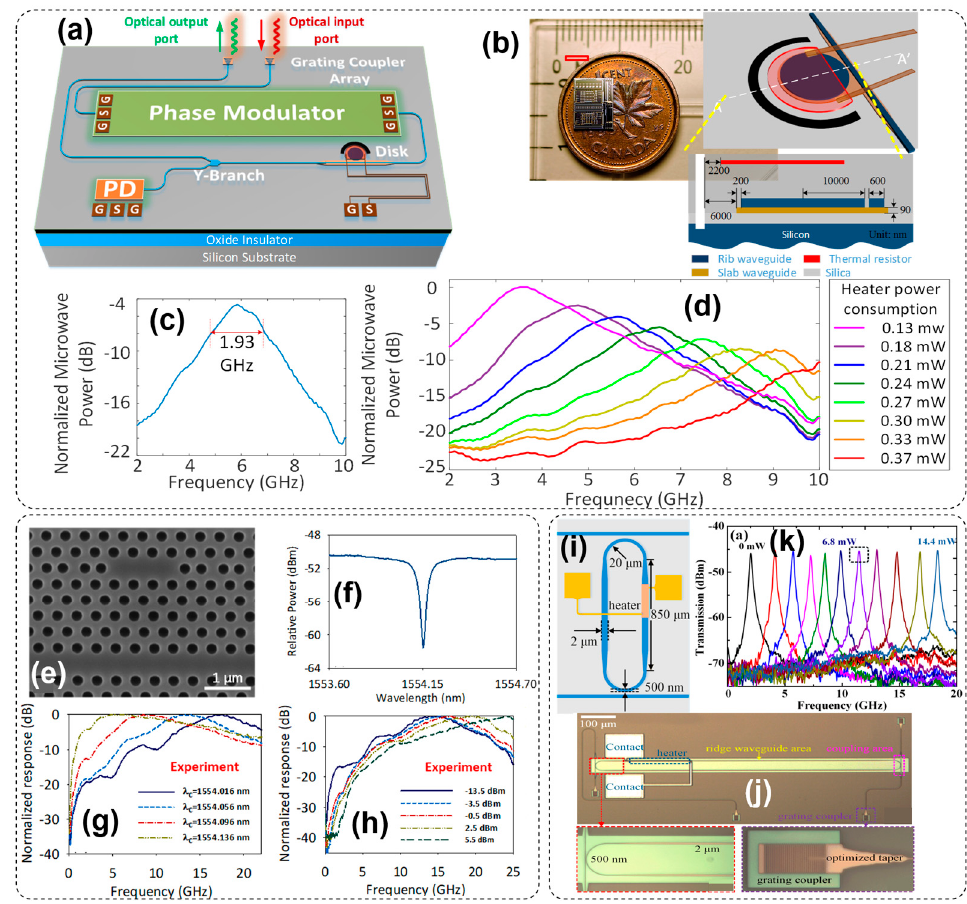
Figure 17. Implemented bandpass MPFs based on silicon micro-resonators. ( a – d ) On-chip integrated MPF based on microdisk resonator (MDR) reported in [61]: ( a ) perspective view of the proposed MPF, ( b ) image of the fabricated silicon photonic chip, schematic view of the thermally tunable MDR, cross-sectional view of the MDR, ( c ) experimental results of MPF and ( d ) measured frequency responses tuning from 3 to 10 GHz. Courtesy of and adapted from Jianping Yao [61]. ( e – h ) Ultracompact bandpass MPF based on a PhC microcavity reported in [105]: ( e ) SEM image, and ( f ) transmission spectrum of the fabricated silicon PhC microcavity, measured MPF responses at ( g ) different optical carrier wavelengths and ( h ) different optical carrier power levels. Courtesy of and adapted from Jian Wang [105]. ( i – k ) Ultranarrow bandpass MPF reported in [106]: ( i ) layout of the used ultra-high-Q MRR, ( j ) image of the fabricated MRR and ( k ) experimental results of tunable bandpass MPF. Courtesy of and adapted from Yuan Yu